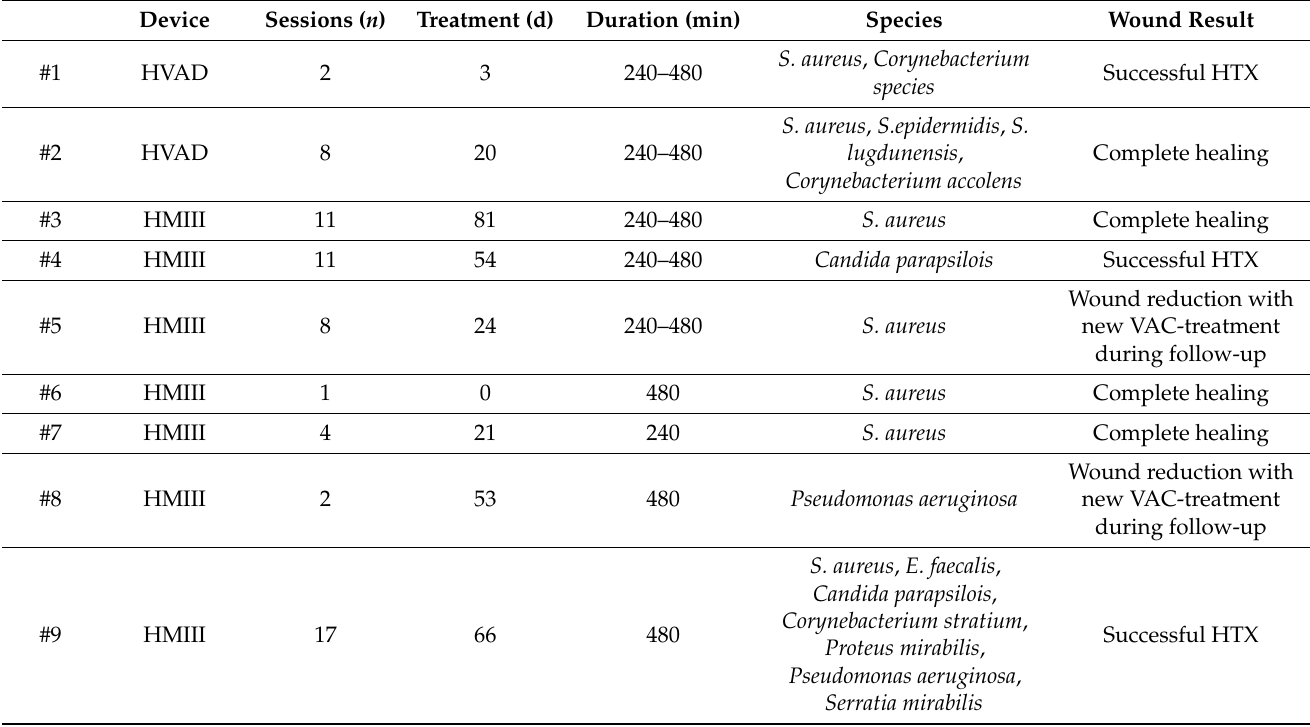
Table 2. Overview CAP treatment